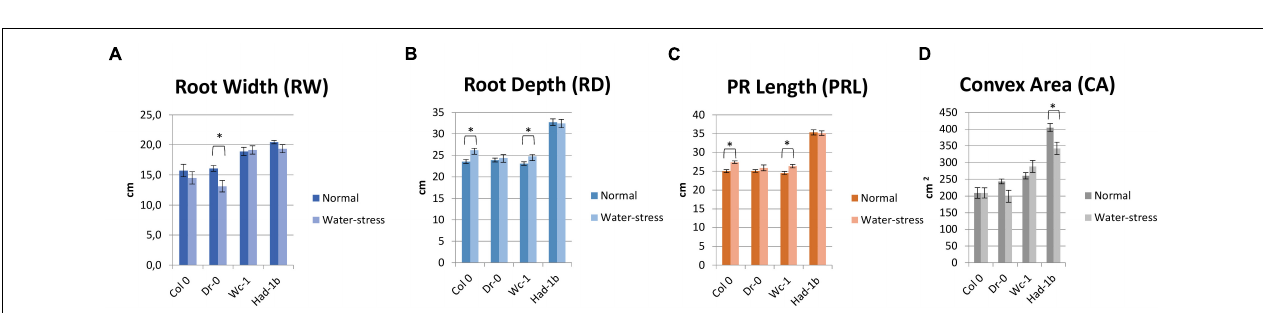
FIGURE 3 | Accessions contrasted width to depth ratio tested in the Rhizotron study. Wc-1 has a low width to depth ratio and a long primary root length and a high convex area. Had-1b has a high width to depth ratio, long primary root length, and a high convex area. Col-0 has an intermediate width to depth ratio, primary root length, and convex area. Dr-0 has a high width to depth ratio but shorter primary root length and a low convex area.